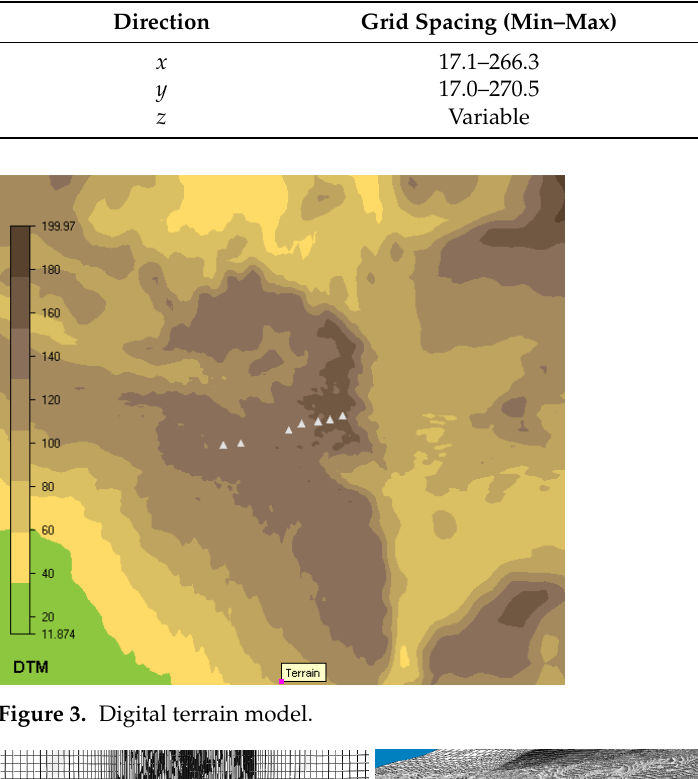
Table 2. Grid specifications.